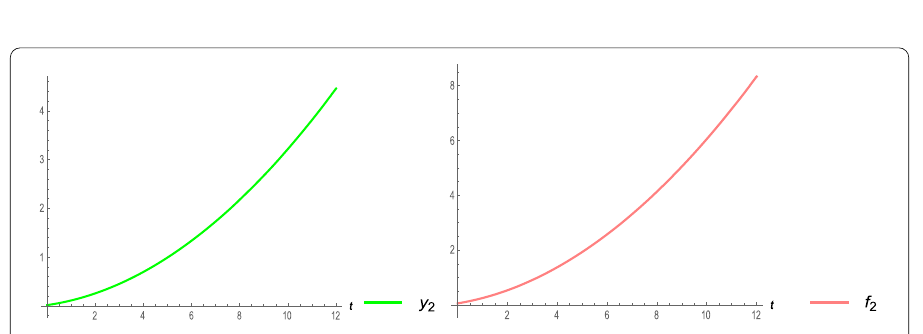
Figure 3 Two-dimensional surfaces of symptomatic infected people and asymptomatic infected people of system (10)